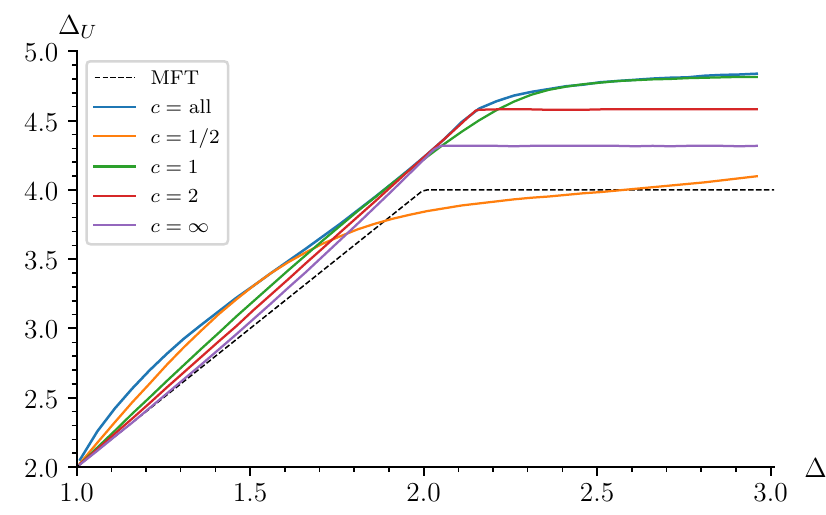
Figure 5 . Upper bound on the dimension ∆ U of the first unprotected operator in the ϕ × ¯ ϕ and M × M OPEs as a function of the dimension of the chiral operator ∆ ϕ . The flavor central charge k is not fixed to a particular value. In the top blue curve, the central charge c is also free, while it takes values c = 1 / 2 , 1 , 2 , ∞ in the curves below it. The black dashed curve is the mean field theory value (4.4). All results are computed with Λ = 24